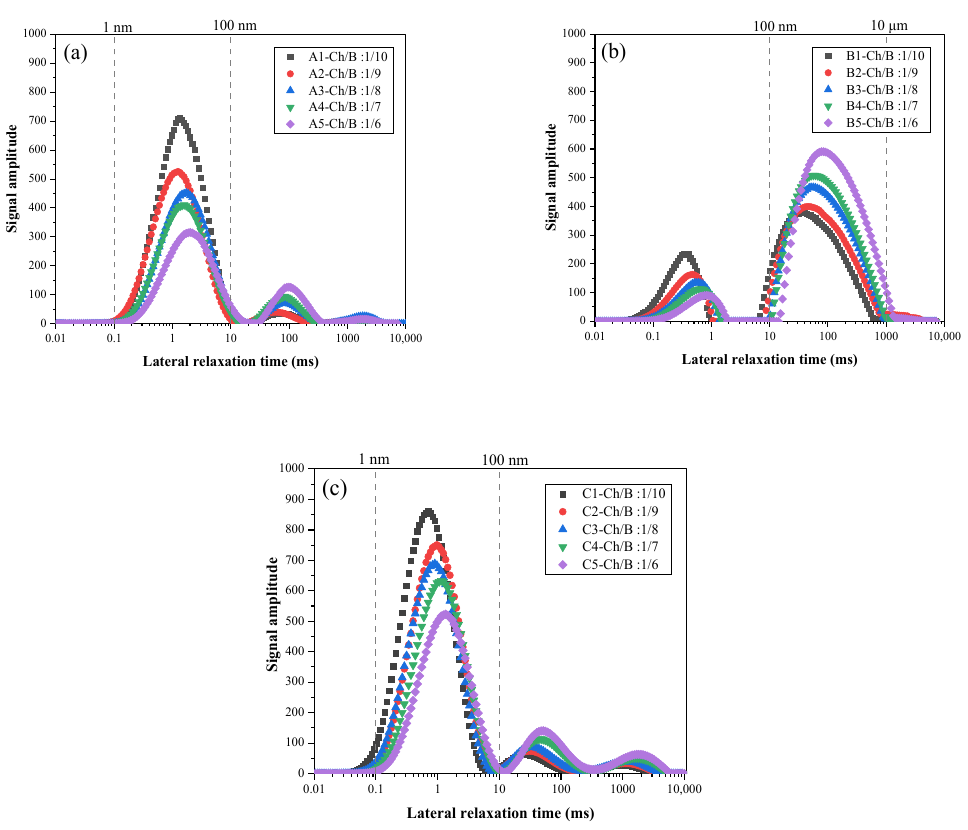
Figure 11. Variation of the T2 spectrum distribution of the different groups: ( a ) T2 spectrum of the SAC specimen; ( b ) T2 spectrum of the OPC specimen; ( c ) T2 spectrum of the GFBS specimen.